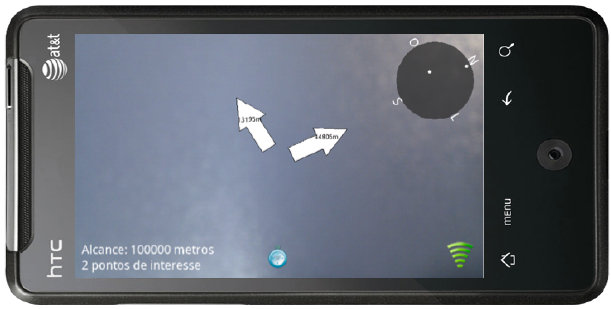
Fig. 5. Device’s camera pointing downwards.